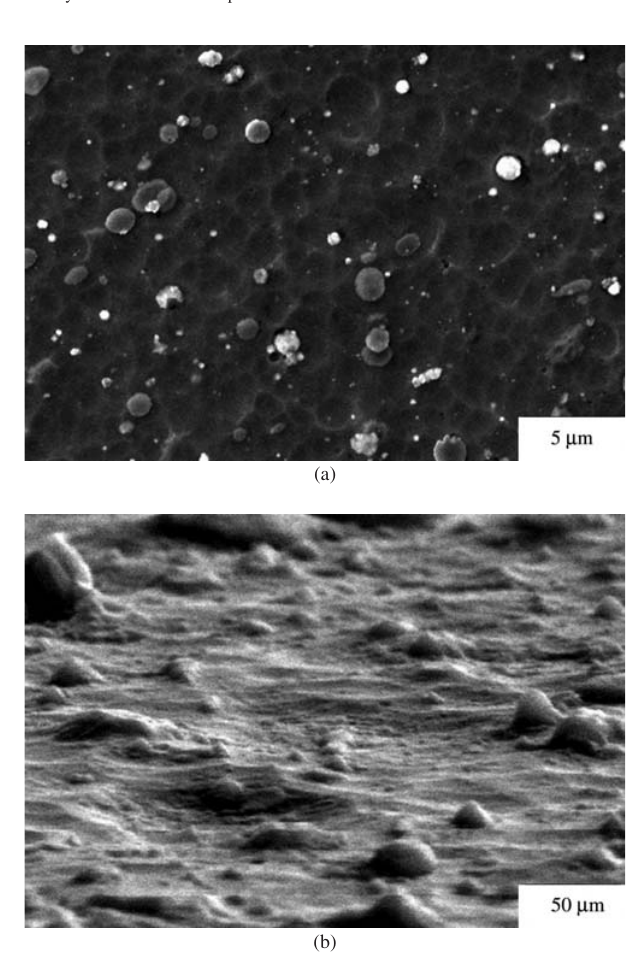
O /TiC coating deposited on the coating deposited on the Figure 4. Topography of the TiN/(Ti,Al,Si)N/TiN coating surface, deposited 2 3 on the W2 type cemented carbide